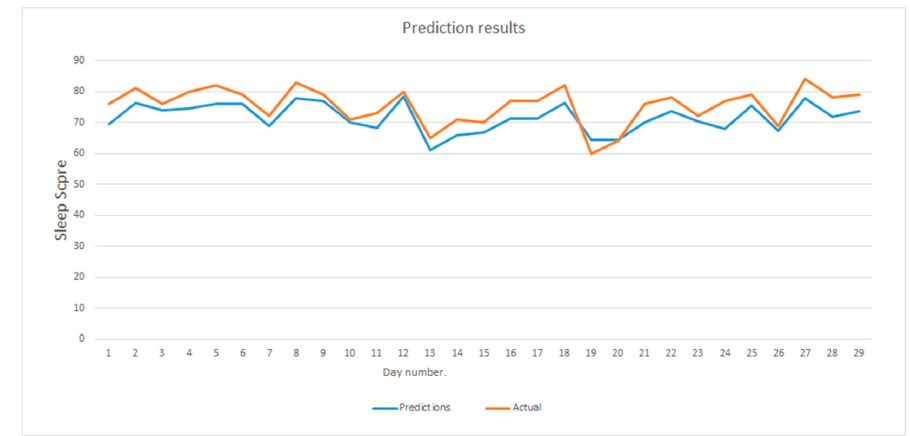
Figure 12. Predicted/actual sleep scores .